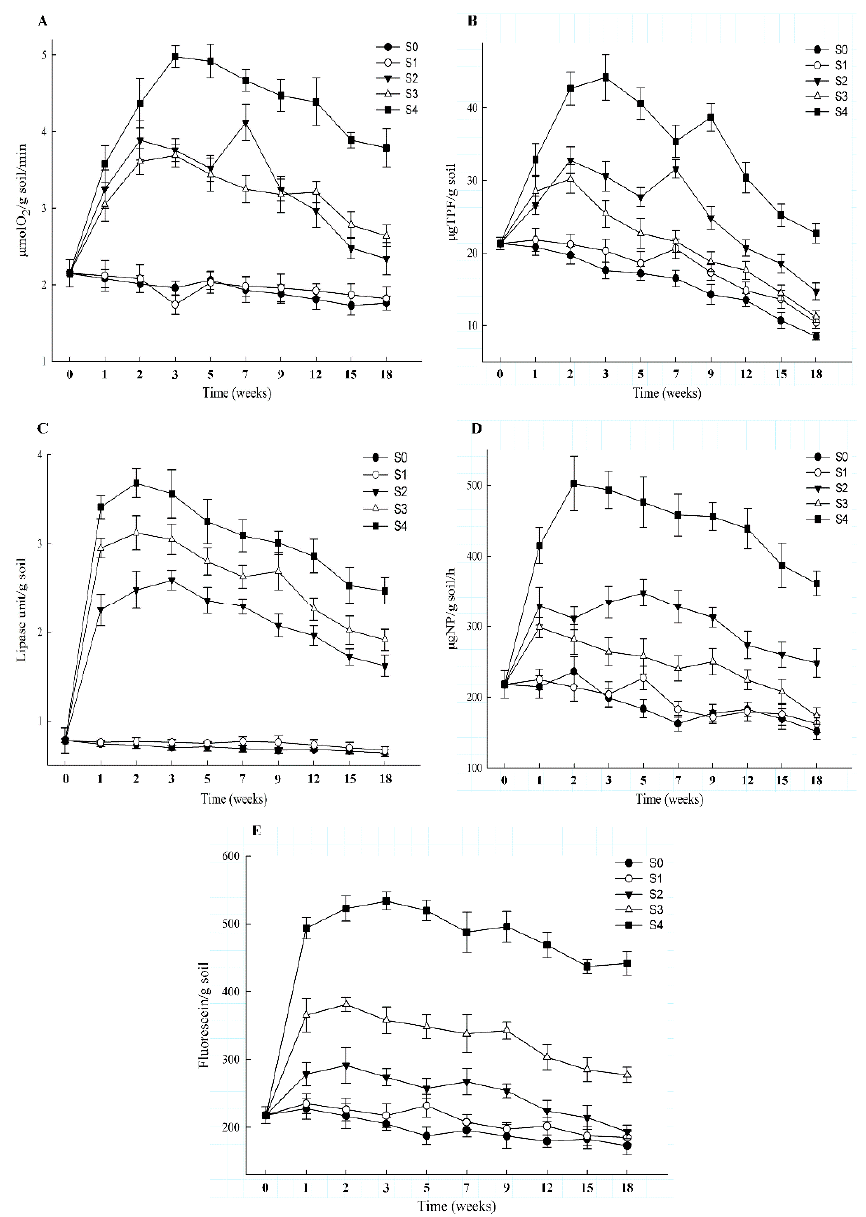
Figure 5. Soil enzyme activities in different remediation strategies. Graphs ( A – E ) represent the activities of CAT, LPS, DDA, PPS, and FDA, respectively.